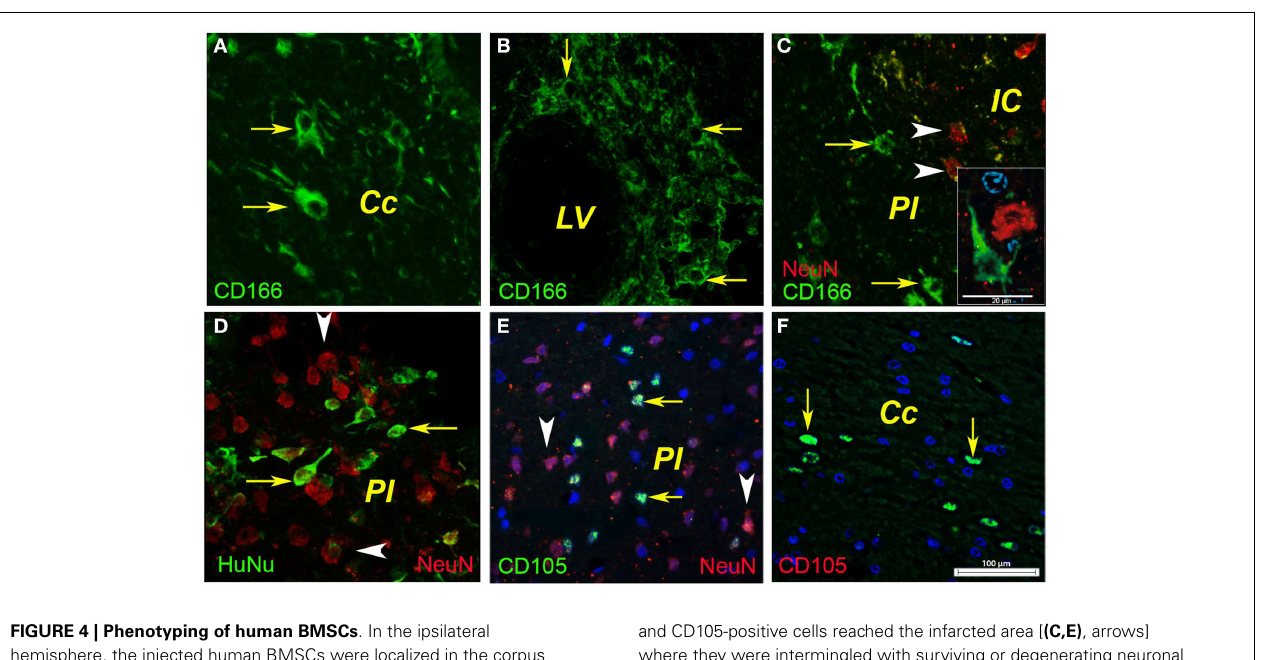
FIGURE 4 | Phenotyping of human BMSCs . In the ipsilateral hemisphere, the injected human BMSCs were localized in the corpus callosum as shown for CD166-positive cells [ (A) , arrows] and CD105-positive cells [ (F) , arrows]. In our model, the cells most likely entered the injured brain via the lateral ventricle as shown by the CD166-positive cells (B) . A fraction (about 1%) of the injected CD166-